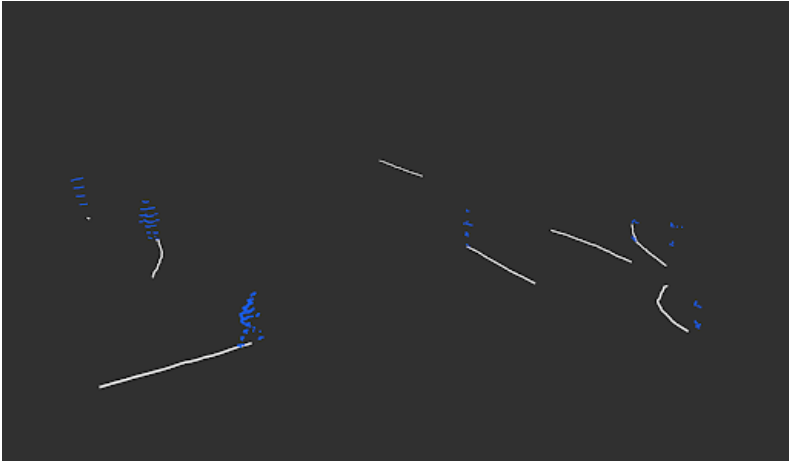
Figure 2. Example of tracked pedestrian trajectories.